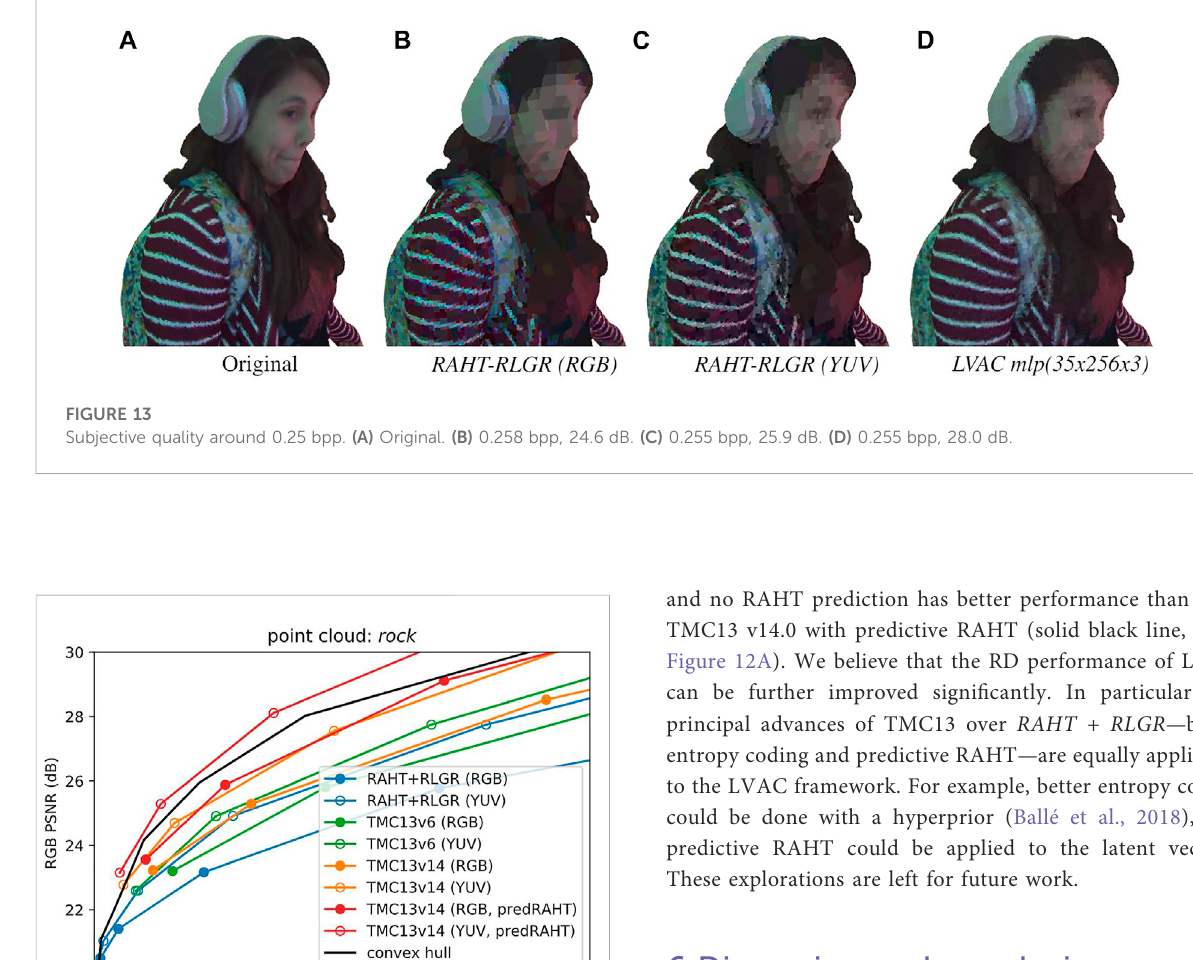
FIGURE 14 Baselines,revisited.InbothRGBandYUVcolorspaces,MPEG G-PCC reference software TMC13 v6.0 improves over RAHT + RLGR , primarily due to context-adaptive (i.e., dependent) entropy coding. TMC13 v14.0 improves still further, primarily due to predictiveRAHT.LVAC(blackline,fromFigure12A)outperformsall but TMC13 v14.0. However, better entropy coding (e.g., hyperprior) and predictive RAHT can also be applied to